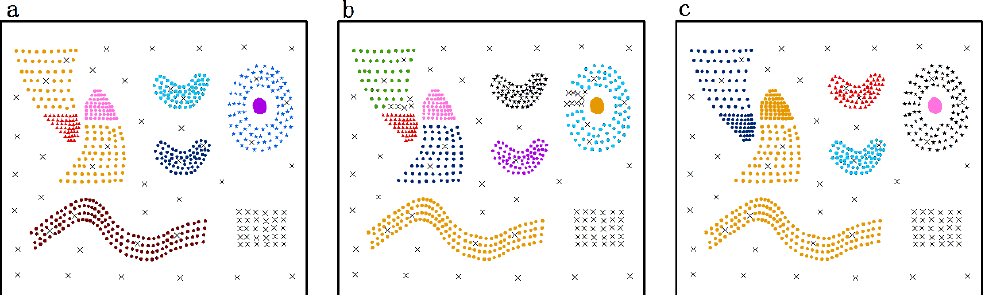
Figure 12. Values of parameter evaluation function Z in 𝑆1 with various 𝛽 .